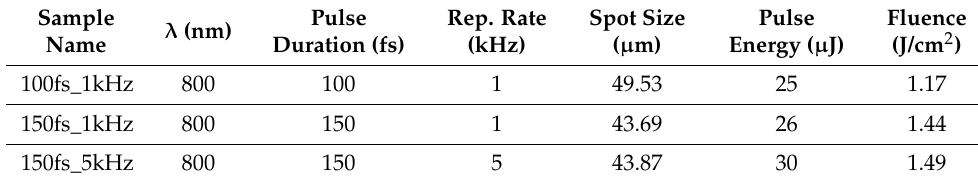
Table 1. Femtosecond lasers parameters used to structure the